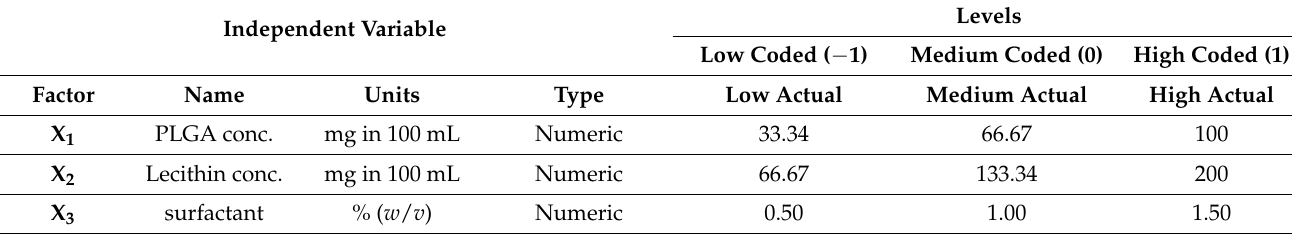
Table 1. Box-Behnken design of the polymer (PLGA)-lipid hybrid nanoparticles (PLNs). Independent